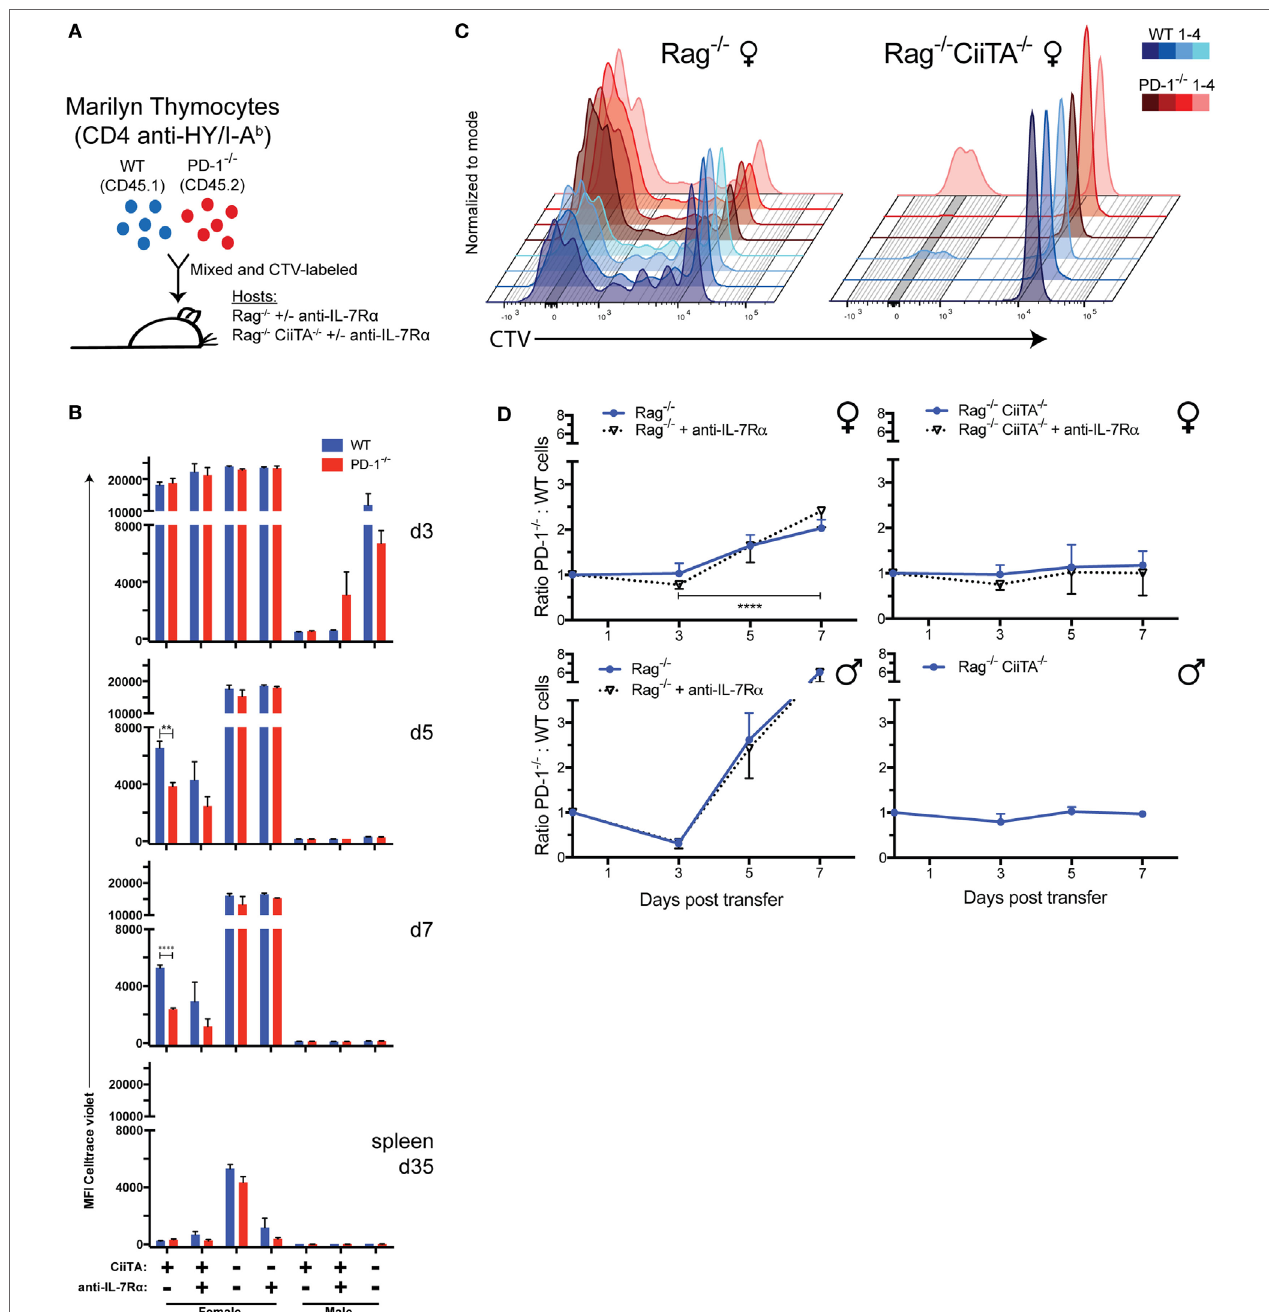
FigUre 1 | Monoclonal CD4 + HY-specific PD-1 − / − T cells out-proliferate and outnumber WT cells during LIP in response to tonic or cognate pMHC-II but independent of IL-7 signals. (a) 40 × 10 6 Celltrace violet (CTV)-labeled mixed Marilyn-WT (CD45.1 + ) and PD-1 − / − (CD45.2 + ) thymocytes were transferred i.v. to Rag − / − or CiiTA − / − × Rag − / − male or female hosts with or without anti-IL-7R α treatment. (B) Mean fluorescence intensity (MFI) of CTV in TCR β + CD4 + WT or PD-1 − / − cells from blood collected at 3, 5, and 7 days and spleen at 35 days post-transfer (p.t.) ± SEM, n = 3–4 per group. ** p < 0.01, **** p < 0.0001, Student’s t -test. (c) Overlaid flow cytometry plots of CTV fluorescence at 7 days p.t. of mixed WT and PD-1 − / − Marilyn thymocytes to Rag − / − and CiiTA − / − × Rag − / − female hosts. Four recipients from one experiment are depicted – with color darkness indicating recipient identity and blue and red hues representing WT and PD-1 − / − cells, respectively, in a given recipient. (D) Ratio of PD-1 − / − to WT CD4 + T cells in blood among indicated recipients at day 3–7 p.t. ± SEM. Data presented are combined from multiple independent experiments as follows: female Rag − / − (four independent experiments, n = 12, 16, 13 per group at days 3, 5, 7 respectively), female Rag − / − + anti-IL-7R α (two independent experiments, n = 4, 8, 8 at days 3, 5, 7), female CiiTA − / − × Rag − / − (four independent experiments, n = 9, 11, 10 at days 3, 5, 7), female CiiTA − / − × Rag − / − + anti-IL-7R α (two independent experiments, n = 3, 5, 5 at days 3, 5, 7), male Rag − / − (two independent experiments, n = 8), male Rag − / − + anti-IL-7R α (two independent experiments, n = 7), male CiiTA − / − × Rag − / − (two independent experiments, n = 8, 7, 8 at days 3, 5, 7). **** p < 0.0001, Student’s t -test, Rag − / − day 3 versus day 7. The starting ratio was normalized and set to a value of one with subsequent ratio measurements scaled accordingly.